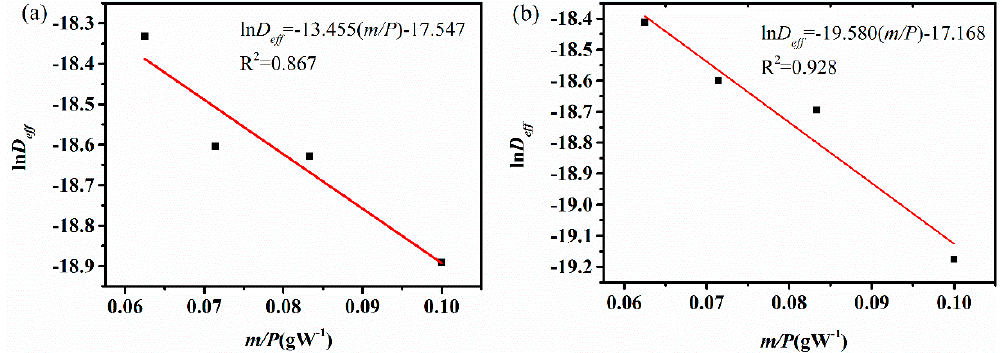
Figure 5. Plot of ln MR versus t of lignite at 100 °C. ( a ) 1st falling rate period; ( b ) 2nd falling rate period.